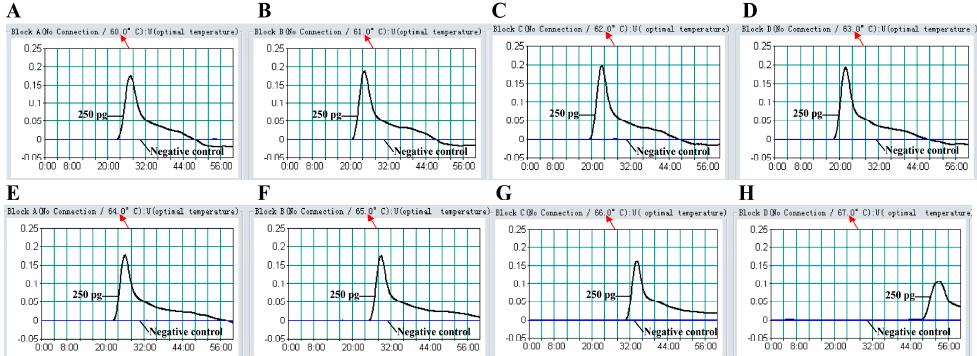
Figure 7. The optimal temperature for the MIP-LAMP assay. The MIP-LAMP amplifications reactions were analyzed by real-time measurement of turbidity and the corresponding curves of concentrations of DNA were marked in the Figure. The threshold value was 0.1 and the turbidity of >0.1 was considered to be positive. Eight kinetic graphs ( A – H ) were obtained at different temperature (60–67 °C) with L. monocytogenes DNA at the level of 2.5 pg per reaction, and the graphs from B to F showed robust amplification.